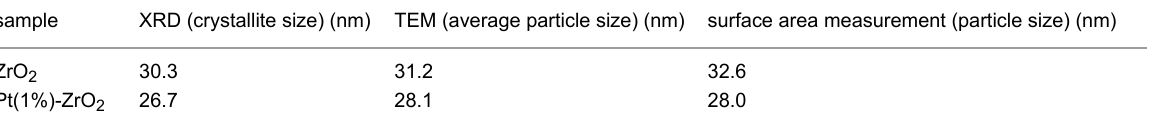
Table 2: Summary of ZrO 2 and Pt(1%)-ZrO 2 particle size from XRD, TEM and surface area measurements. sample